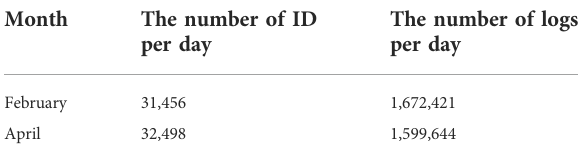
TABLE 1 Number of daily IDs and logs of GPS data per day in each month of